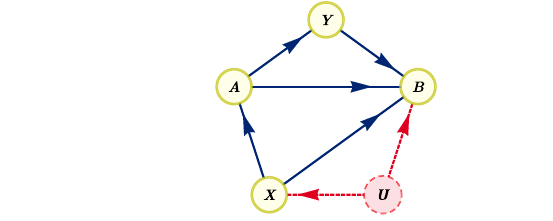
FIG. 16. A graph admitting multiple causal explanations for correlation between A and B